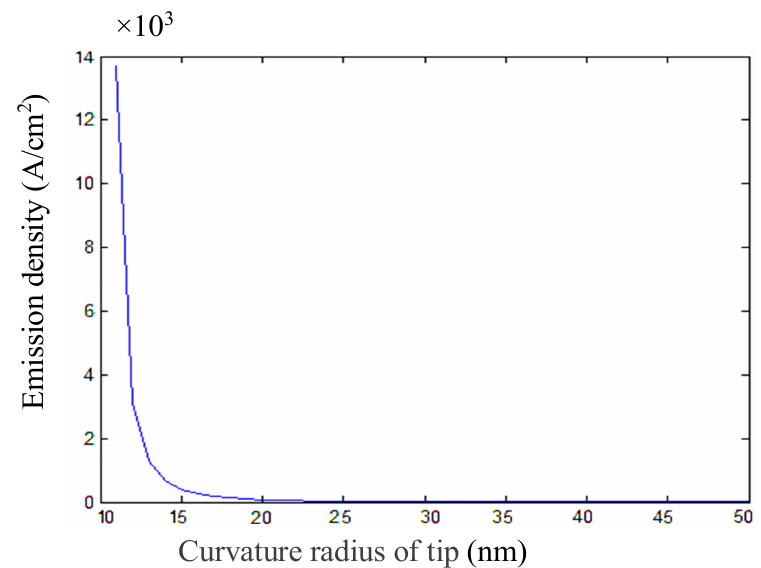
Figure 2. Emission current density vs the curvature radius of the tip.